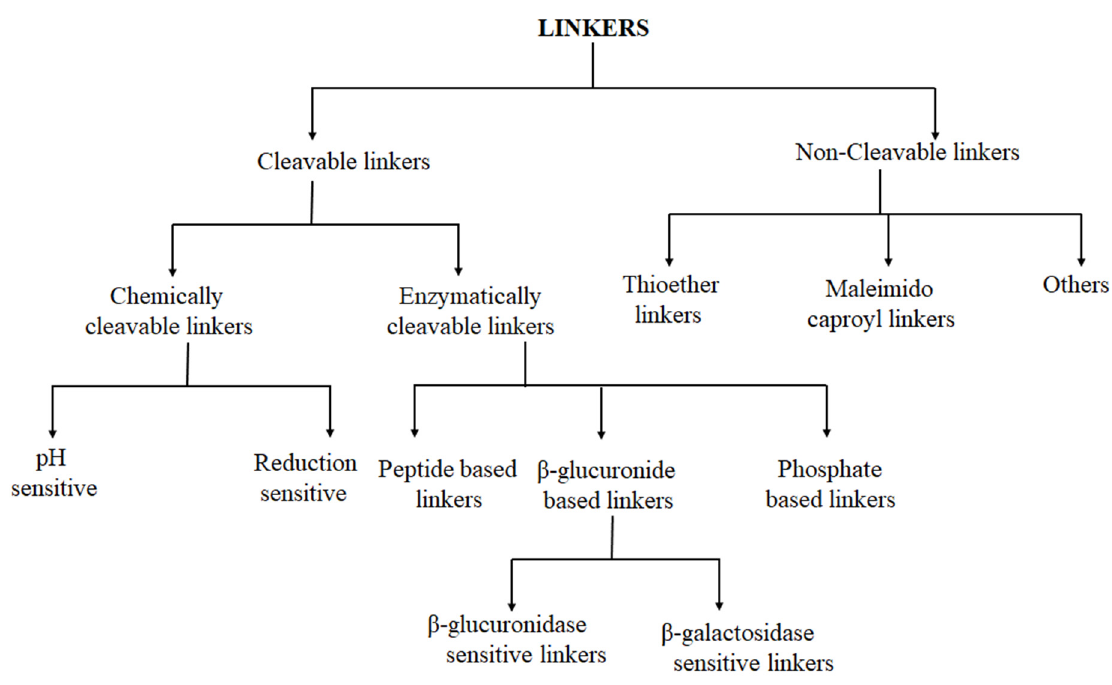
Figure 3. Classification of linkers in ADCs.